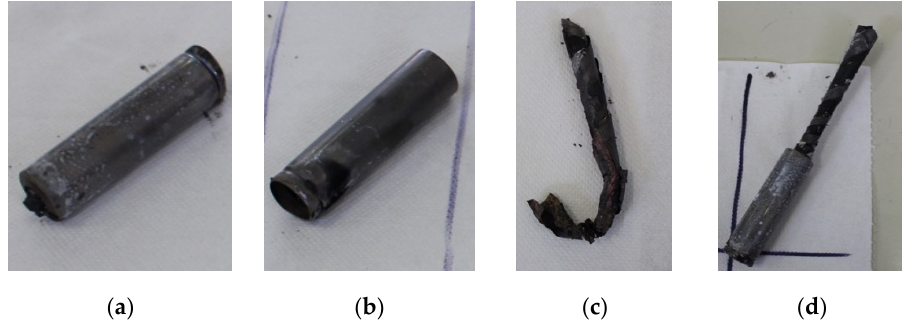
Figure 4. Cell residues after cone calorimeter tests at: ( a ) 15 kWm − 2 , 100% SoC ( b ) 50 kWm − 2 , 100% SoC ( c ) 50 kWm − 2 , 50% SoC and ( d ) 50 kWm − 2 , 0% SoC.